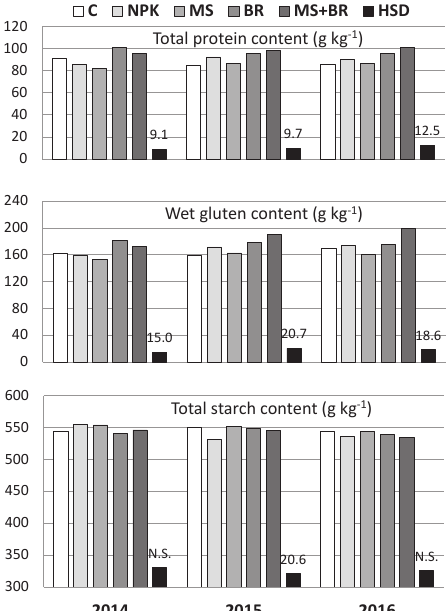
Fig. 1. Effect of biogas digestate (BD) and mining waste (mudstones -MS) on the protein, gluten and starch contents of winter wheat grain (n = 3); C = control (podzolic soil – PS without fertilization); NPK = PS + N, P, K, Mg, Ca, S (120 N,